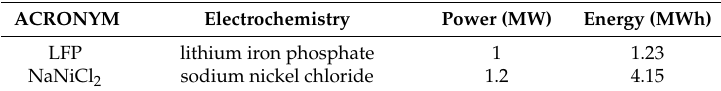
Table 2. Storage lab of Ciminna (Sicily) installed secondary